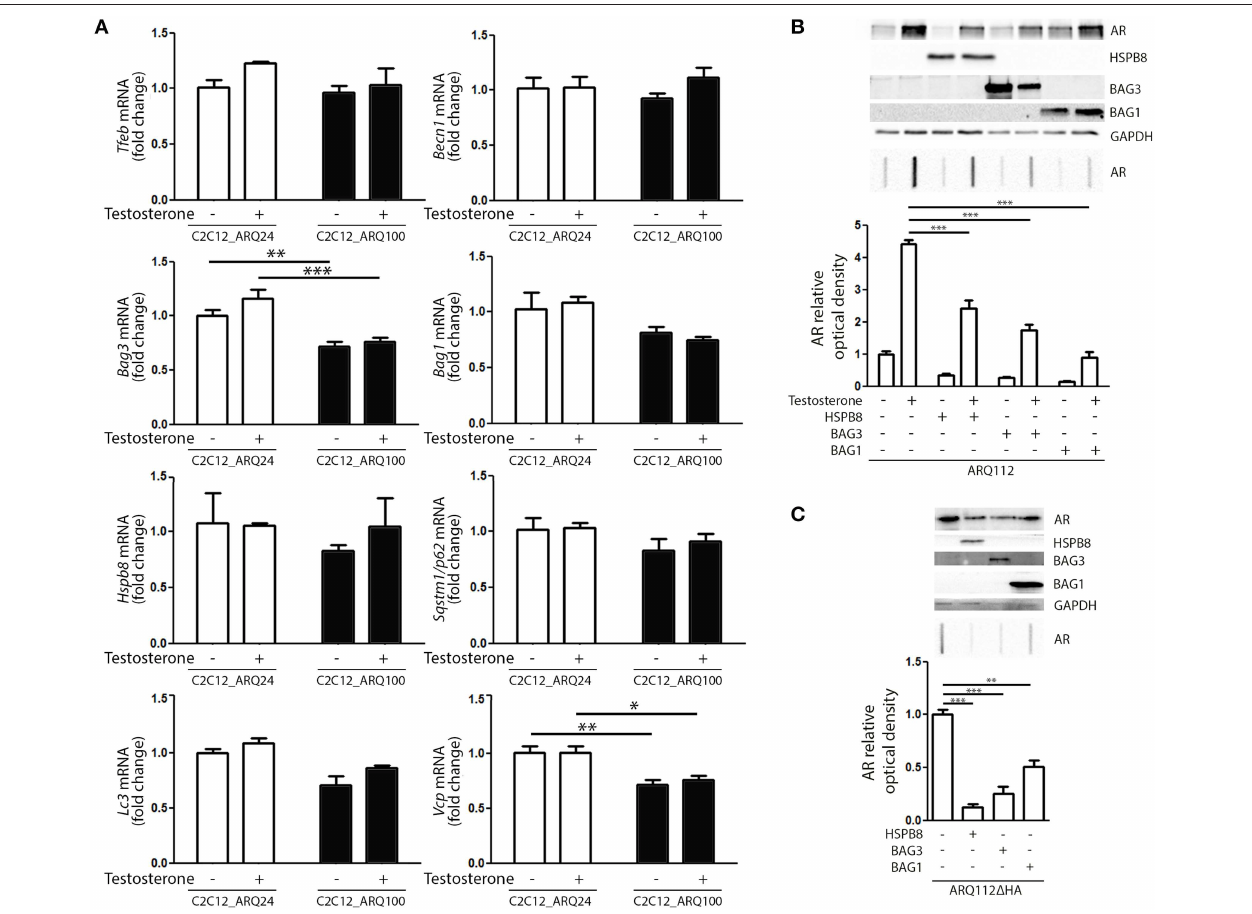
FIGURE 3 | PQC activation and role against AR accumulation. (A) RT-qPCR of PQC system related genes performed on C2C12_ARQ24 and C2C12_ARQ100. * p < 0.05; ** p < 0.01; *** p < 0.001 vs. ARQ24 in the same conditions. Graphs show quantification of four independent biological samples ( n = 4). (B) WB (upper inset) and FRA (middle inset) of C2C12 transiently transfected with p5HBhARQ112 and co-transfected with plasmids coding for HSPB8, BAG3 and BAG1. Optical densitometry quantification of FRA (lower inset). (*** p < 0.001 vs. relative control conditions + T). (C) WB (upper inset) and FRA (middle inset) of C2C12 transiently transfected with pARQ112 1 HA and co-transfected with plasmids coding for HSPB8, BAG3 and BAG1. Optical densitometry quantification of FRA (lower inset). (** p < 0.01; *** p < 0.001 vs. relative control conditions pcDNA3). Each experiment was independently replicated three times. Graphs show quantification of three independent biological samples ( n =